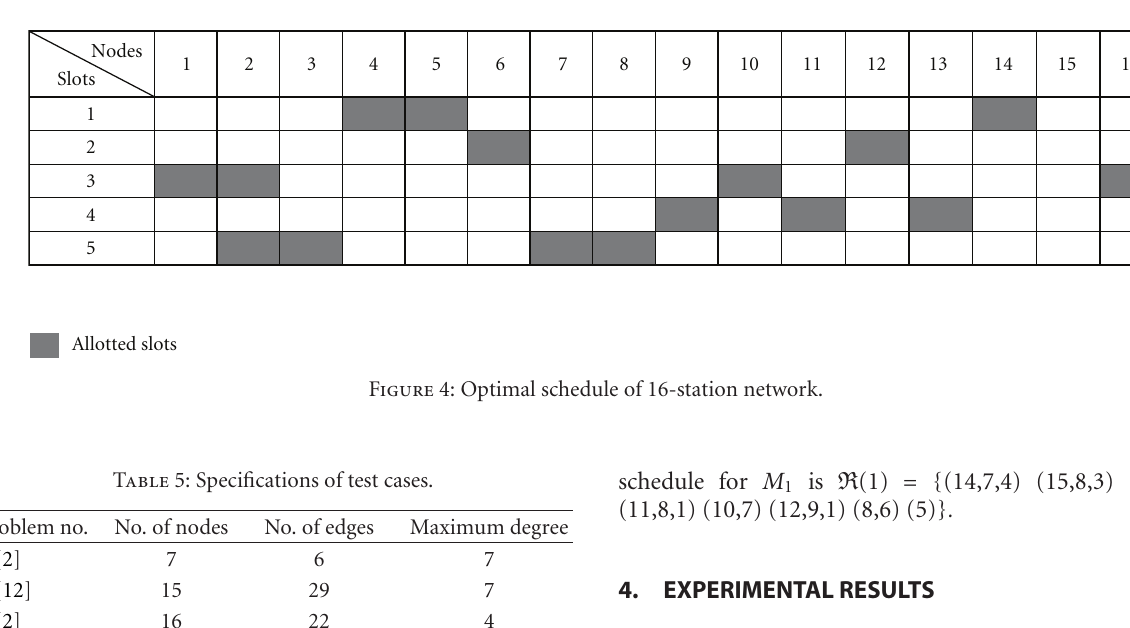
Figure 3: Optimal schedule of 15-station network.